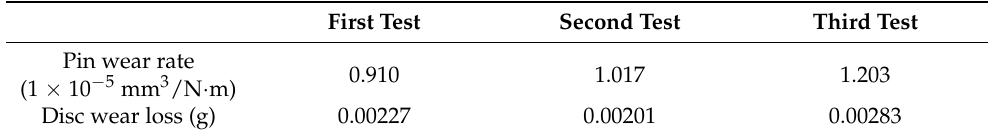
Table 3. Wear loss of 5 wt.% Cr 3 C 2 cladding layer in repeated tests.